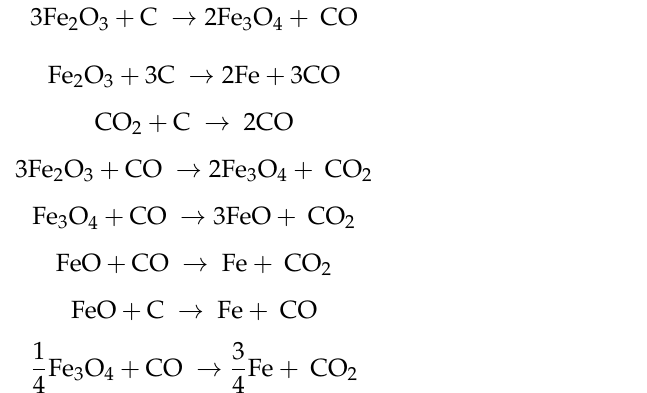
Figure 9b, an etched SEM image of an interdendritic eutectic mixture of pearlite and ce- mentite is shown.